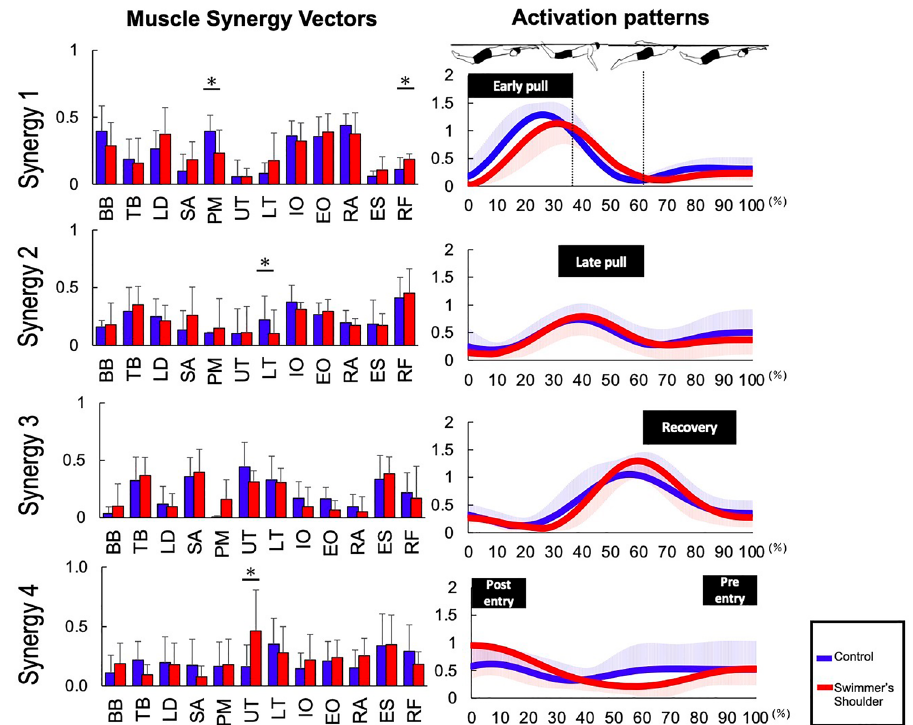
Figure 4. The muscle synergy vectors are shown on the left side of the figure aligned to the corresponding activation coefficient. The synergy activation patterns are shown on the right side of the figure. BB, biceps brachii; TB, triceps brachii; LD, latissimus dorsi; SA, serratus anterior; PM, pectoralis major; UT, upper trapezius; LT, lower trapezius; IO, internal oblique; EO, external oblique; RA, rectus abdominal; ES, erector spinae; RF, rectus